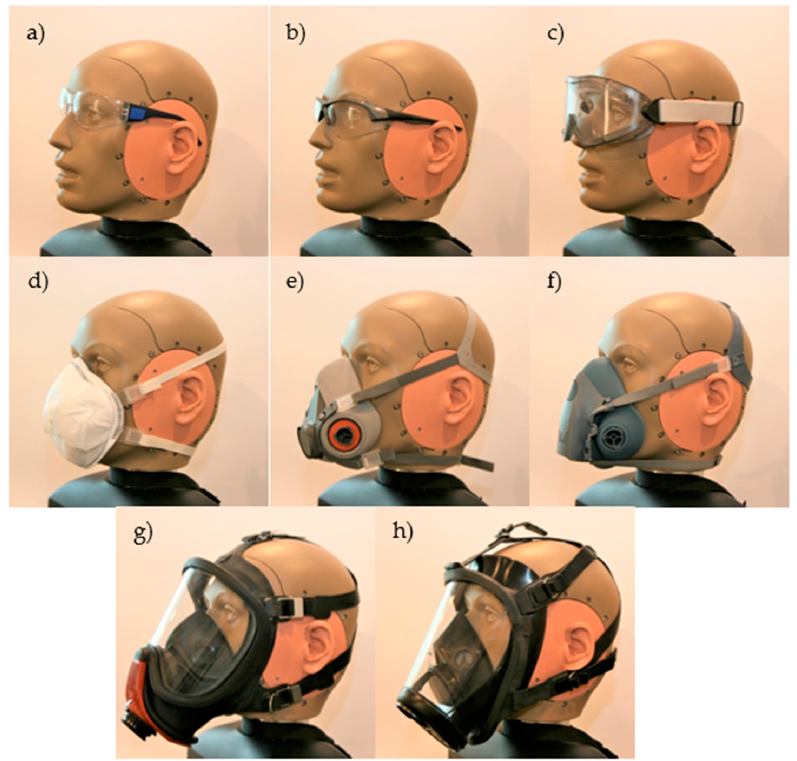
Figure 2. Tested other personal protective equipment (OPPE): ( a ) safety spectacles SS1, ( b ) safety spectacles SS2, ( c ) goggles G, ( d ) disposable respirator DR, ( e ) reusable half respirator RHR1, ( f ) reusable half respirator RHR2, ( g ) reusable full face respirator RFFR1, and ( h ) reusable full face respirator RFFR2.